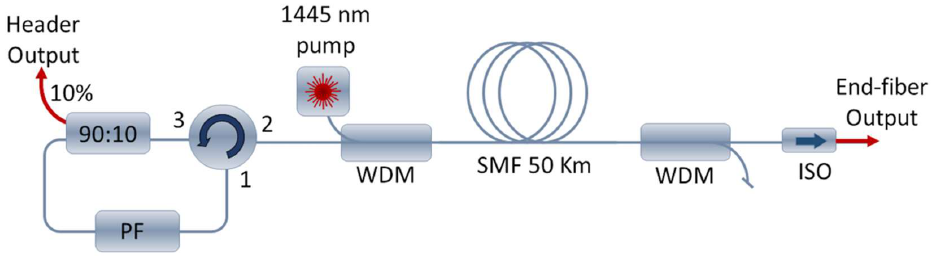
Figure 1. Schematic of the RDFL setup (PF: programmable filter; WDM: wavelength division multiplexer; ISO: isolator).